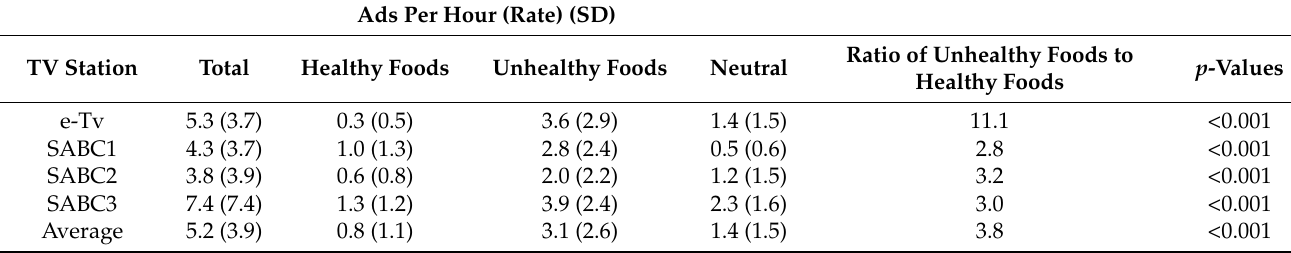
Table 3. Mean advertisement rate by television (TV)